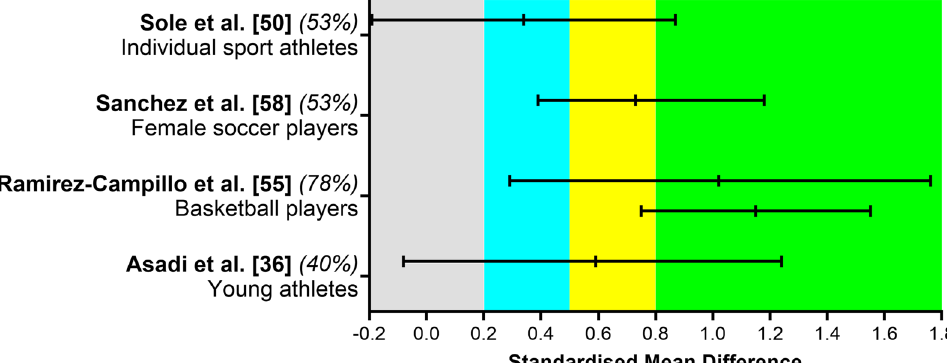
Fig. 3 Summary of standardized mean difference and 95% confidence intervals reported in meta‑analyses comparing the baseline to post‑plyometric training changes on change of direction performance. Author name and year are followed by the quality of the studies score ranked by AMSTAR 2. Positive values represent improved performance effects and negative values detrimental effects. Each colored area represents a different magnitude of effect: gray, trivial; blue, small; yellow, moderate; and green, large effects. Ramirez‑Campillo et al. [53] reported results from > 40‑ and < 40‑m testing distances, presented in the respective